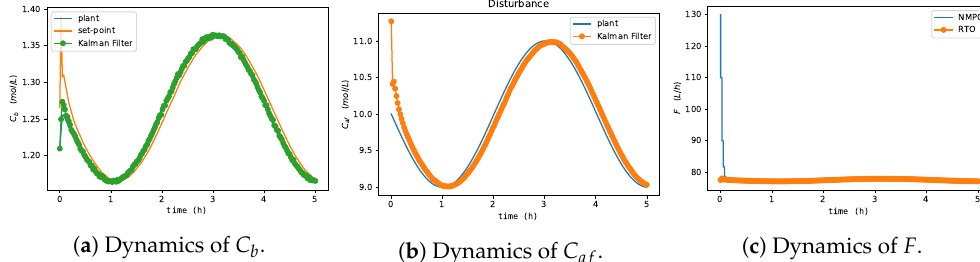
Figure 13. HRTO approach to Van de Vusse reactor economic optimization and control concerning process disturbances of Figure